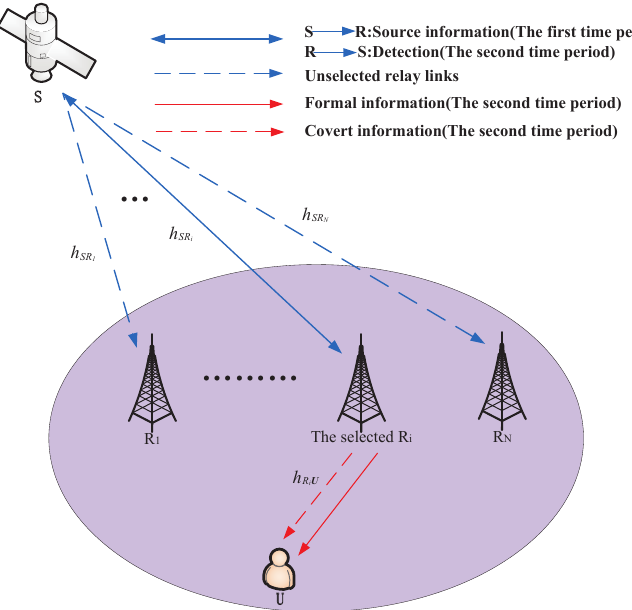
Figure 1. Covert communication system based ISMTRN with partial relay